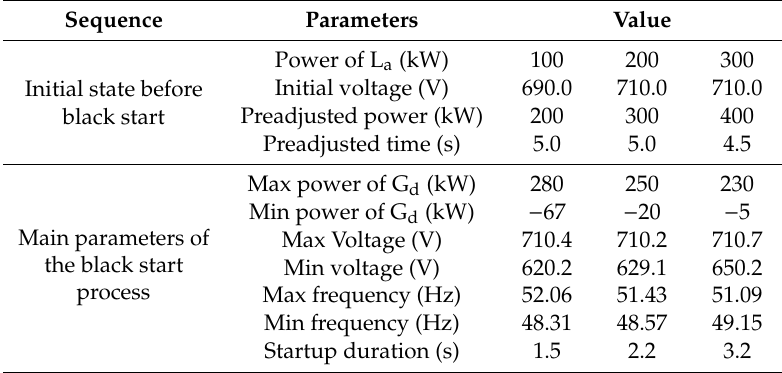
Table 4. The list of parameters for starting simulation auxiliary